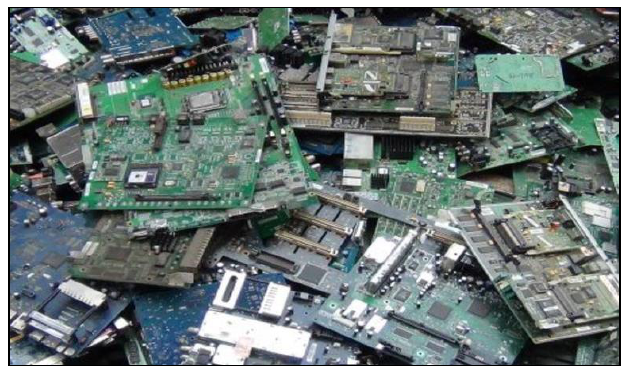
Figure 1: Scenario of